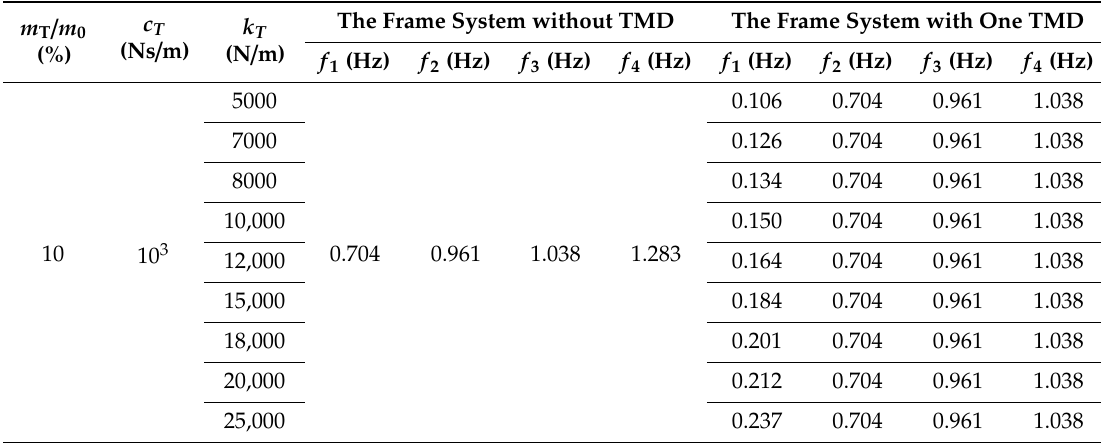
Table 9. Variation of the first natural frequencies of the space frame system as a function of k T .